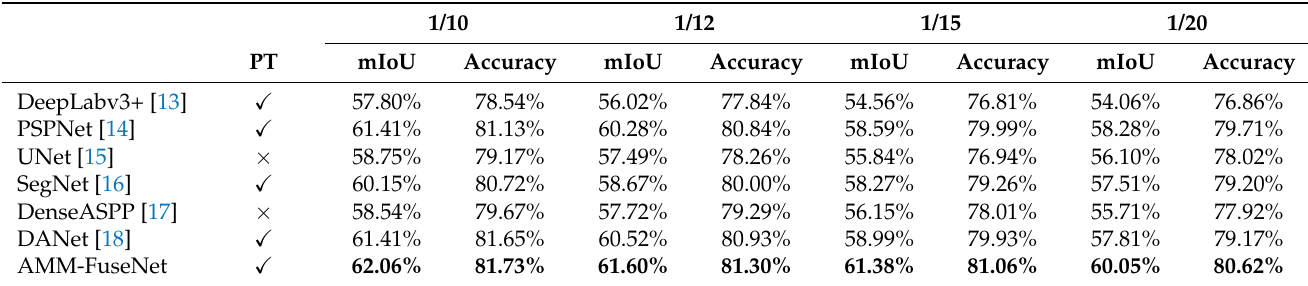
Table 12. Performance comparison of different methods on the Potsdam data for reduced number of training samples in terms of mIoU and accuracy ( (cid:88) : Initial backbone with pre-trained (PT) weights on ImageNet. × : Initial backbone Randomly).